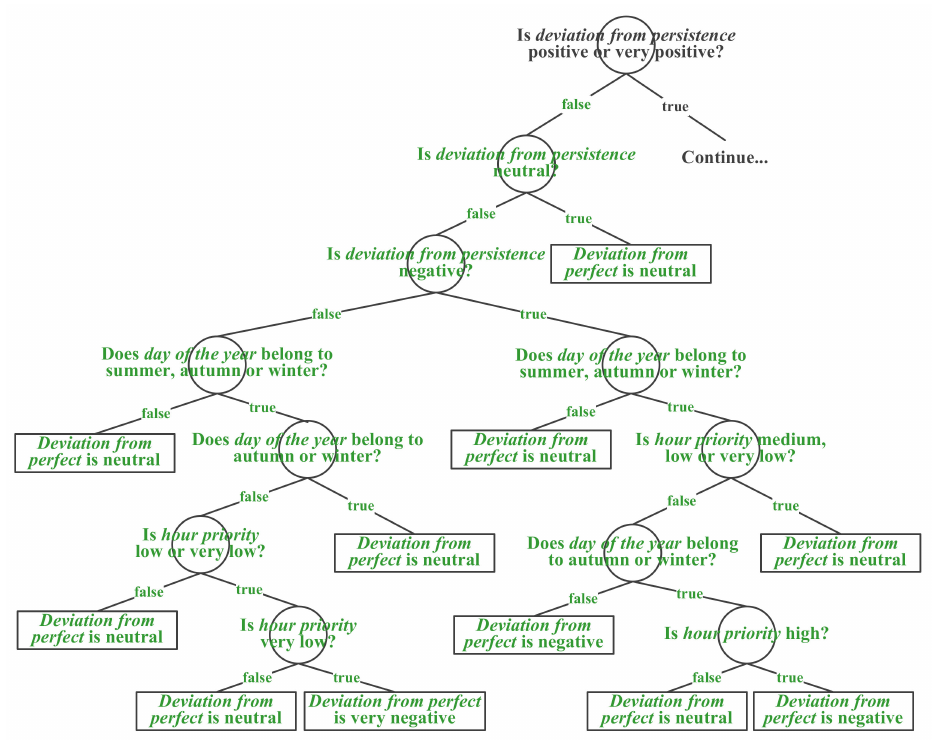
Figure 6. Part of a pruned branch of the decision tree for the CSP plant application. The final branch is represented in green in Figure